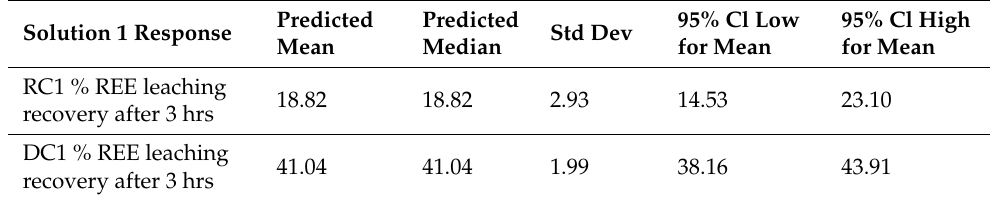
Table 9. Point prediction table for the optimised selected solutions.